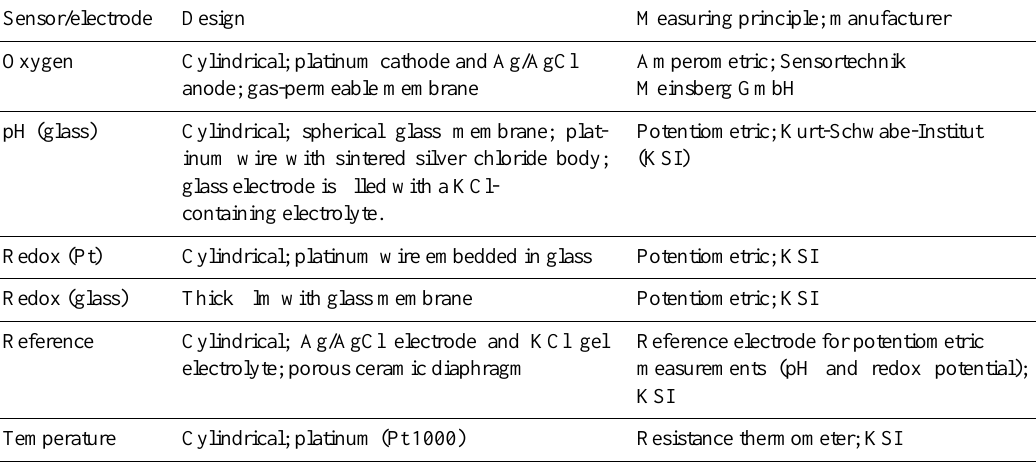
Table 1. Overview of the sensors installed in the on-site analysis system.